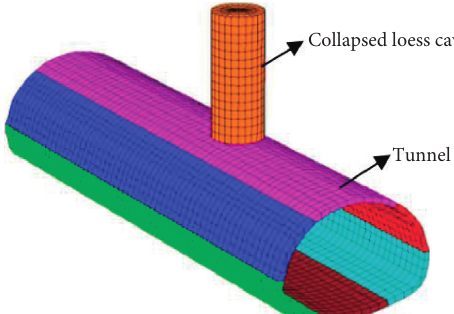
Figure 25: Diagrammatic sketch of collapsed loess cave and tunnel.